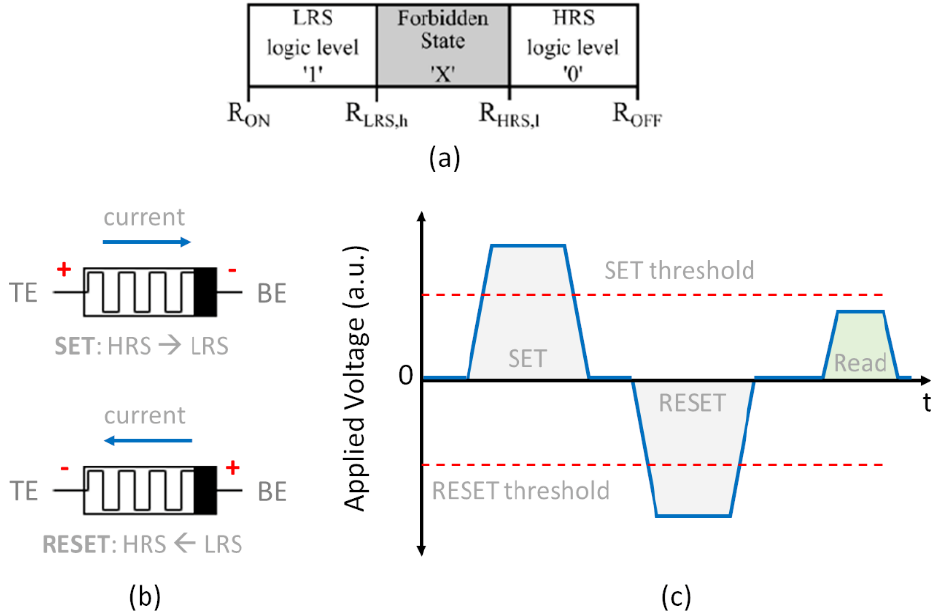
Figure 1. ( a ) Memristance range and HRS/LRS correspondence with logic “0”/“1”. Intermediate forbidden state is defined by the highest LRS and the lowest HRS, respectively. ( b ) Memristor switching behavior when forward or reverse-biased. TE/BE stand for Top/Bottom Electrode. ( c ) Cartoon plot showing the required voltage pulses, which are higher than the switching thresholds, to be applied for SET/RESET memory write operations (light gray shade), and pulses of lower am- plitude used for memory read operations (light green shade). Dashed horizontal lines denote the SET/RESET thresholds.